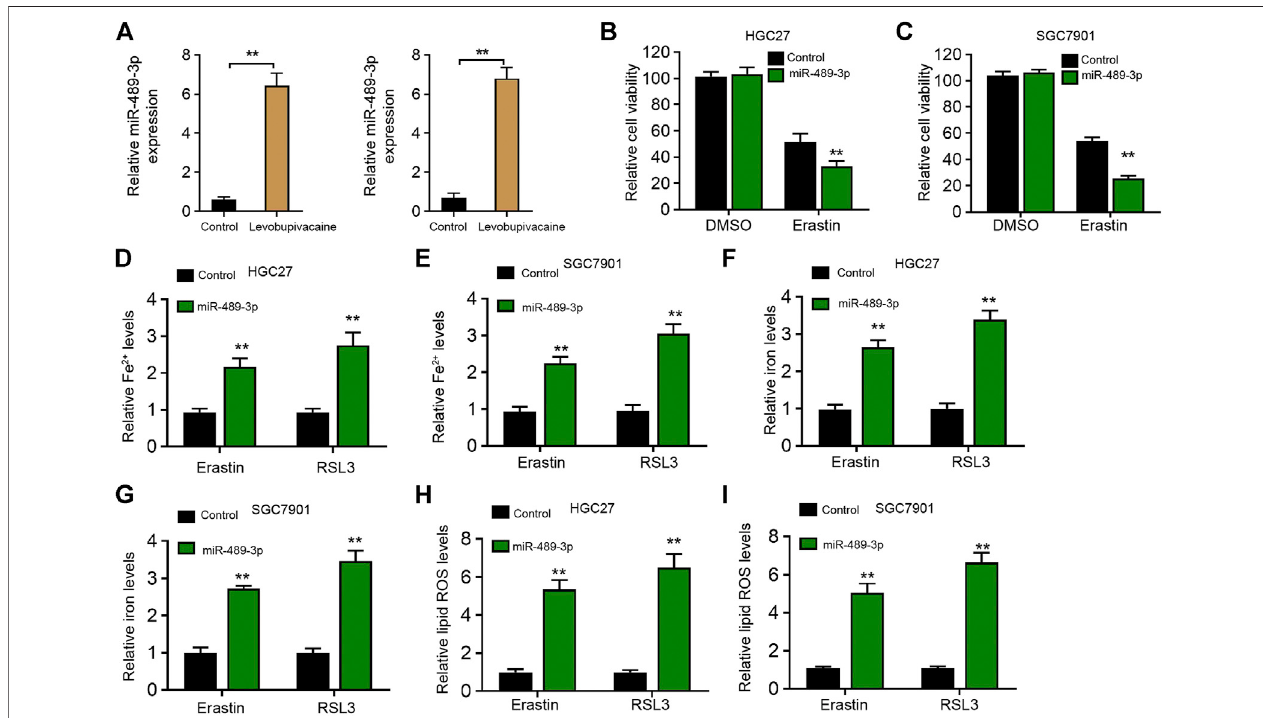
FIGURE 4 | Levobupivacaine-upregulated miR-489-3p enhances ferroptosis of gastric cancer cells. (A) HGC27 and SGC7901 cells were treated with saline or levobupivacaine (2 mM). The qPCR analysis of miR-489-3p expression. (B,C) HGC27 and SGC7901 cells were co-treated with erastin (5 μ M) and miR-489-3p mimic. MTT assays for cell viability analysis. (D – I) The erastin (5 μ M) and RSL3 (1 μ M)-stimulated HGC27 and SGC7901 cells were treated with miR-489-3p mimic. The Fe 2+ (D,E) , iron (F,G) , and ROS levels (H,I) were analyzed. The experiments were performed independently three times (mean ± SD, ** p < 0.01).